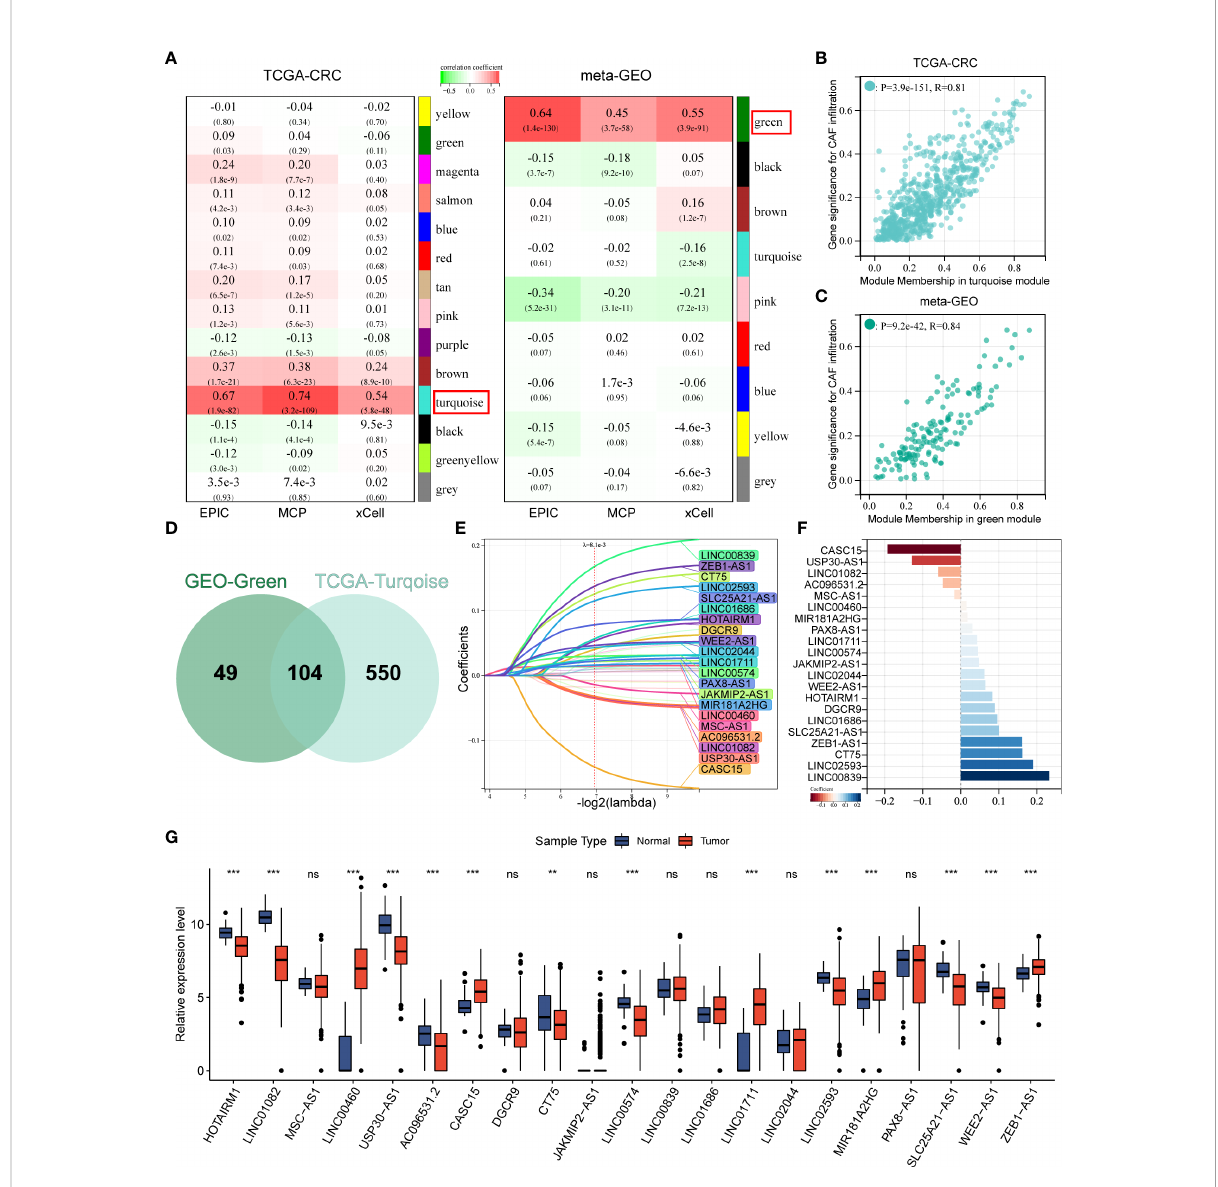
FIGURE 2 WGCNA identi fi ed CAFDL and LASSO analysis. (A) WGCNA identi fi ed modules associated with CAF in fi ltration calculated by EPIC, MCPcounter, and xCell in TCGA-CRC and meta-GEO cohorts. (B) Correlation between gene signi fi cance for CAF in fi ltration and module membership in turquoise module in TCGA-CRC cohort. (C) Correlation between gene signi fi cance for CAF in fi ltration and module membership in green module in meta-GEO cohort. (D) A Venn diagram showing the number of lncRNAs in the turquoise module in the TCGA-CRC cohort and the green module in the meta-GEO cohort. (E) LASSO analysis identi fi es 21 CAF-derived lncRNAs. (F) Multivariate Cox analysis calculated the coef fi cient for each lncRNA in the CAFDL signature. (G) Expression of 21 CAF-derived lncRNAs in CRC and normal tissues. **P < 0.01, ***P < 0.001, NS non-signi fi